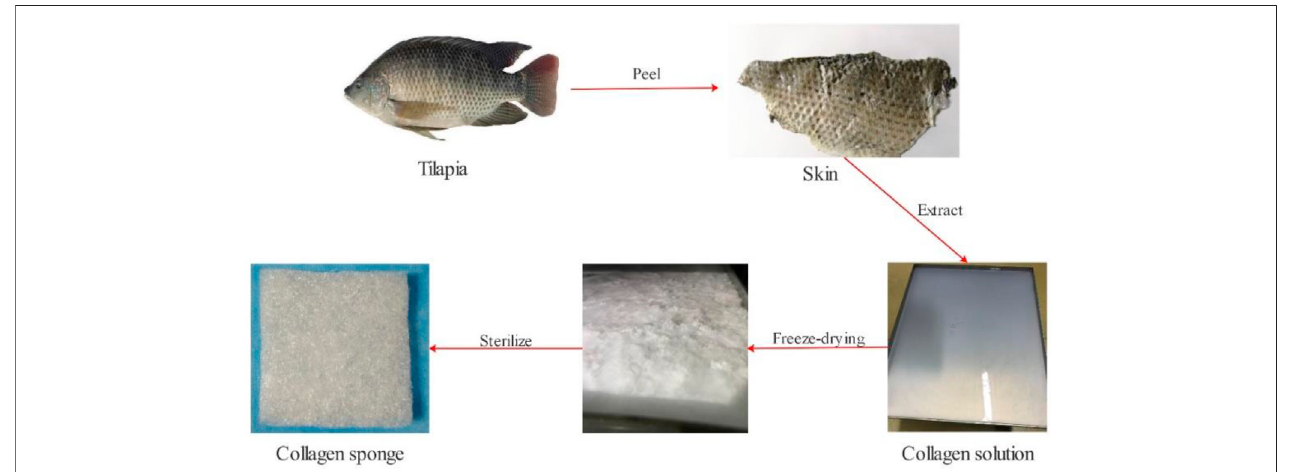
FIGURE 1 | Extraction of tilapia collagen protein and preparation of